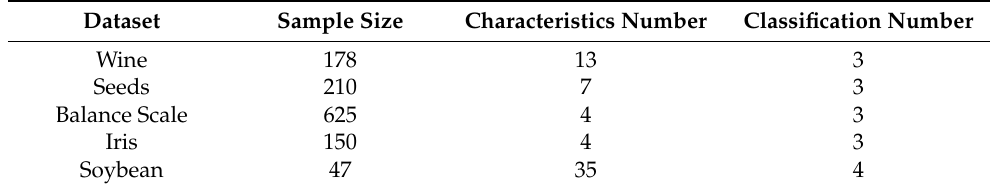
Table 3. Data and Characteristics.